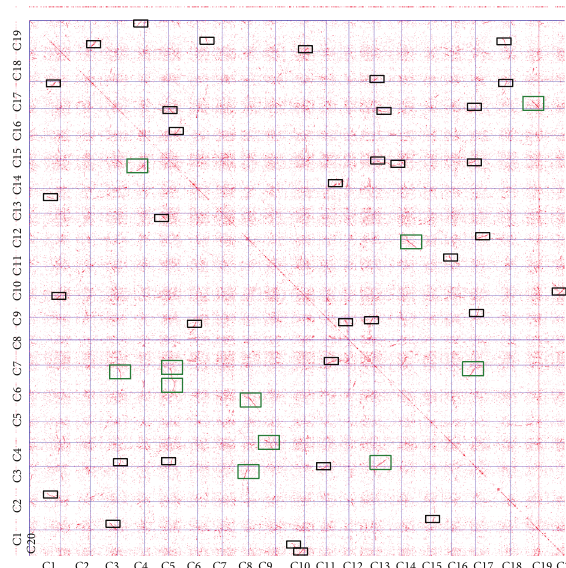
Figure 2: The dot plot of soybean